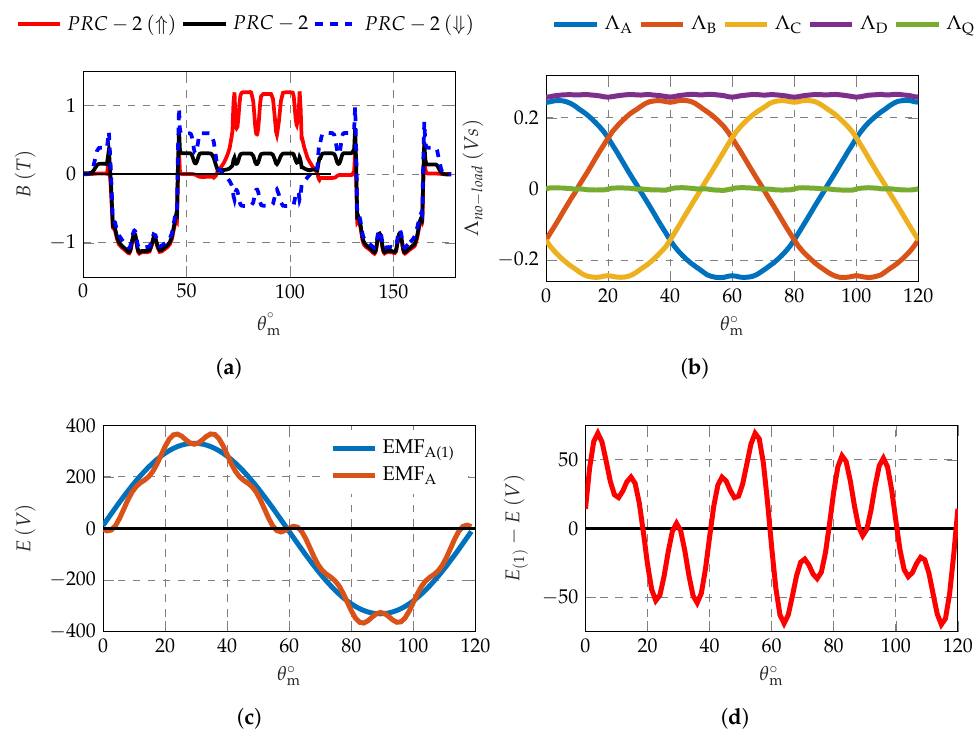
Figure 12. Flux density, electro-magnetic force and flux linkage of the PRC-2 machine. ( a ) Air gap flux density distribution versus rotor position. ( b ) No-load stator flux linkage versus rotor position. ( c ) Electro-magnetic force versus rotor position. ( d ) Difference between actual and main EMF harmonic versus rotor